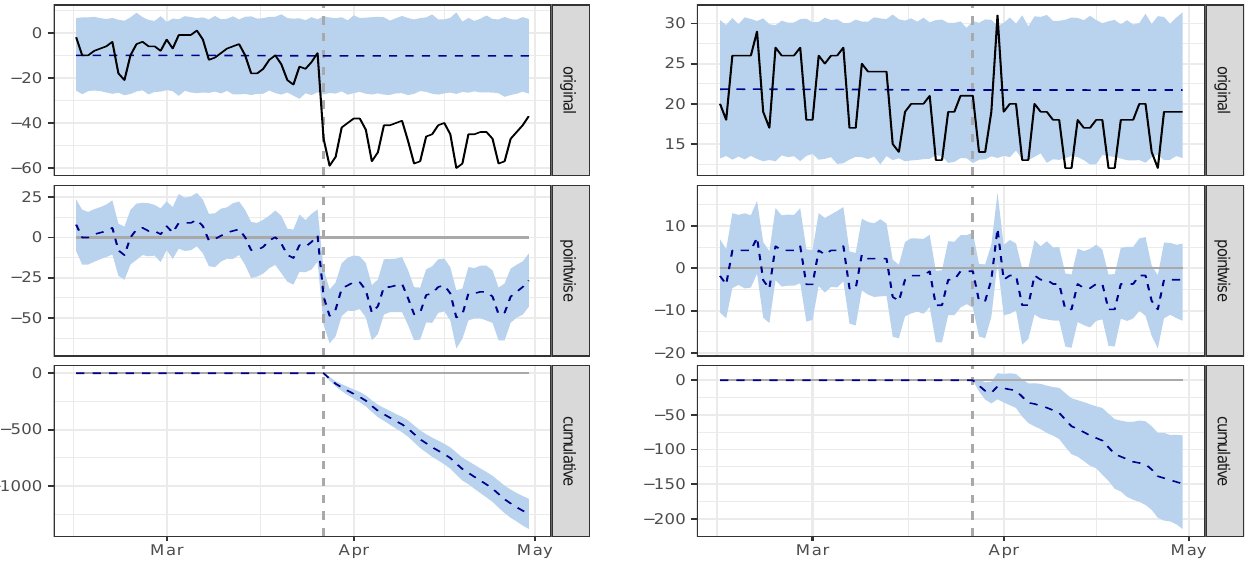
Figure 11. Left : Effect of the national full lockdown Level 5 on parks Right : Effect of the national full lockdown Level 5 on residential